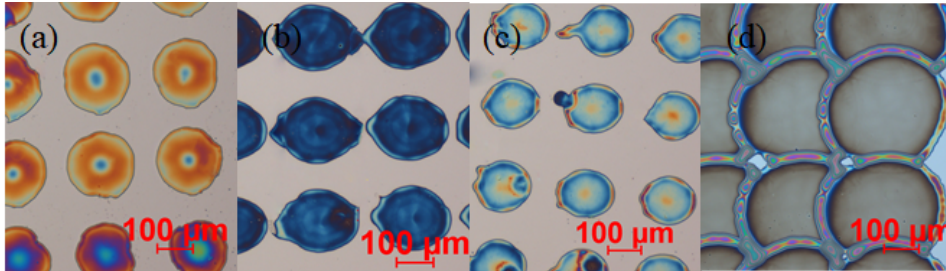
Figure 4. Micrographs of PEI dots deposited on differently prepared surfaces: ( a ) only standard cleaning, ( b ) dehydration bake, ( c ) HMDS pretreatment, ( d ) RIE O 2 plasma